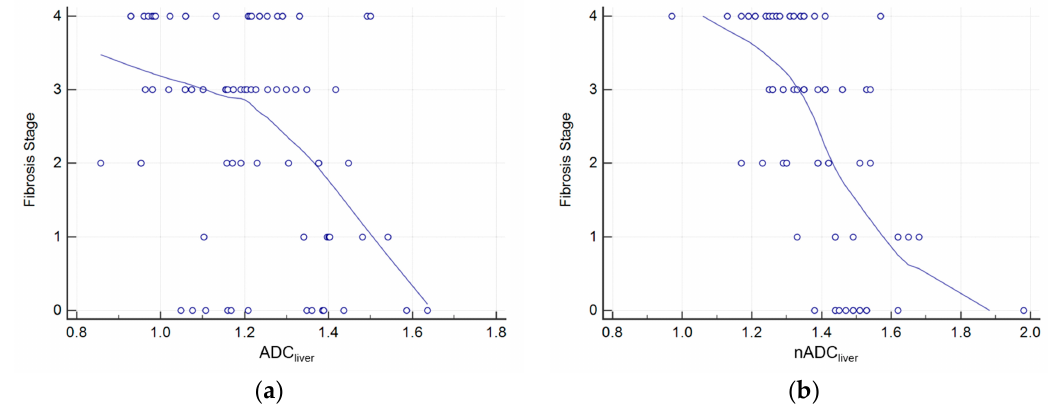
Figure 2. Scatter plot of Spearman’s rank correlation test between liver fibrosis stage and liver ADC before ( a ) and after ( b ) normalization.